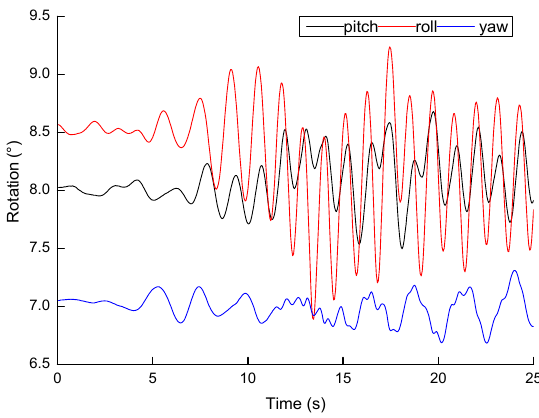
Figure 16. The angle variations of scheme 3 in the mooring experiment.